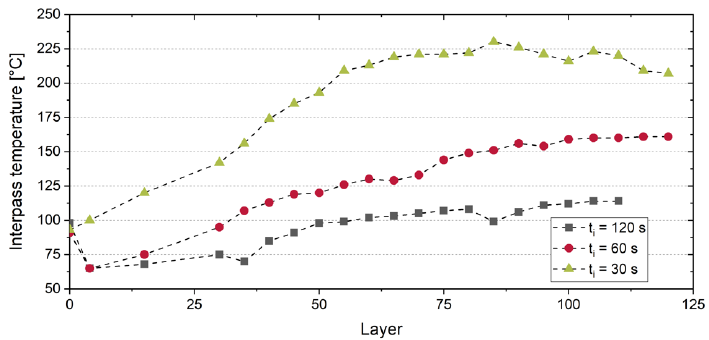
Figure 4. Interpass temperature depending on number of layers and intermediate time between layers by example of Series B specimen.